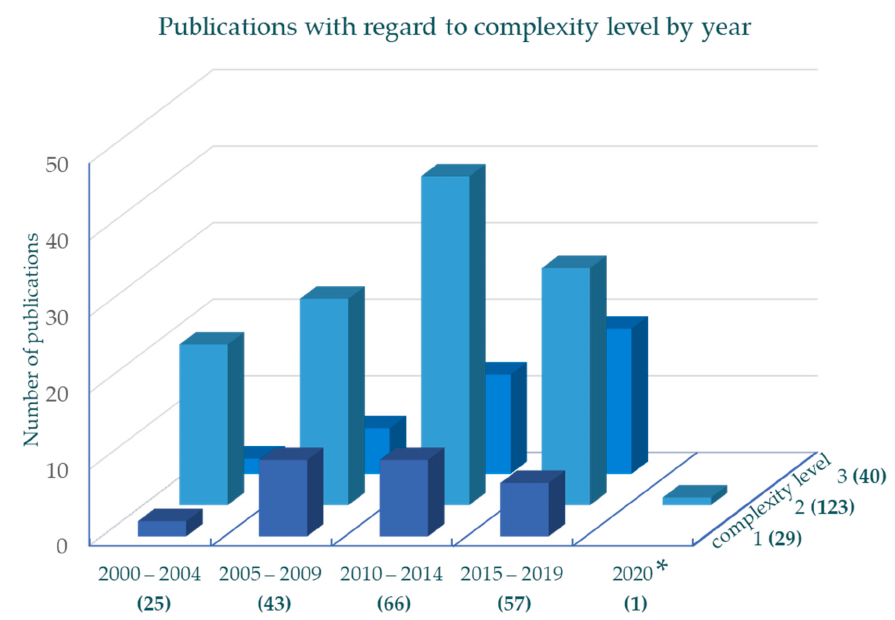
Figure 3. Distribution of studies in the period from 2000 to 2020 with regard to complexity level (for definitions, see “Section 2”). The number of the respective publications is shown in brackets. * status